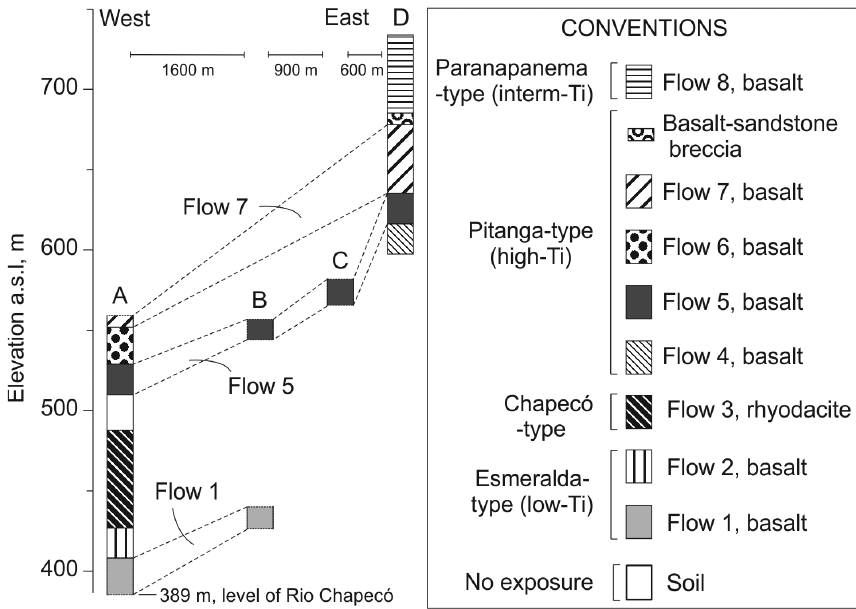
Figure 8 - Correlation chart of the lava flows in the Entre Rios mining district. Fault-block structures caused downthrow of the flows to the